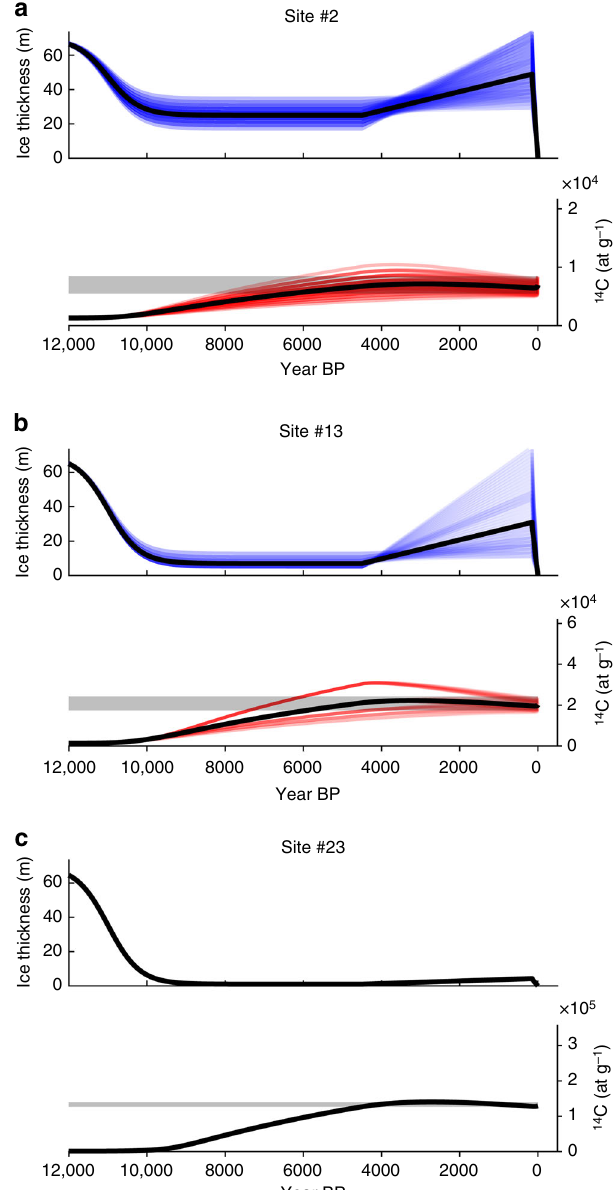
Fig. 3 Example of ice cover and in situ 14 C simulations. Model output for the lowest ( a ), intermediate ( b ), and highest ( c ) in situ 14 C inventory locations showing the range of ice cover histories (blue lines) for the past 12 ka that yield in situ 14 C concentrations (red lines) within uncertainty of the measured 14 C (gray bar). Individual simulations are shown as colored lines, median shown as solid black line. See Supplementary Figs. 3 and 4